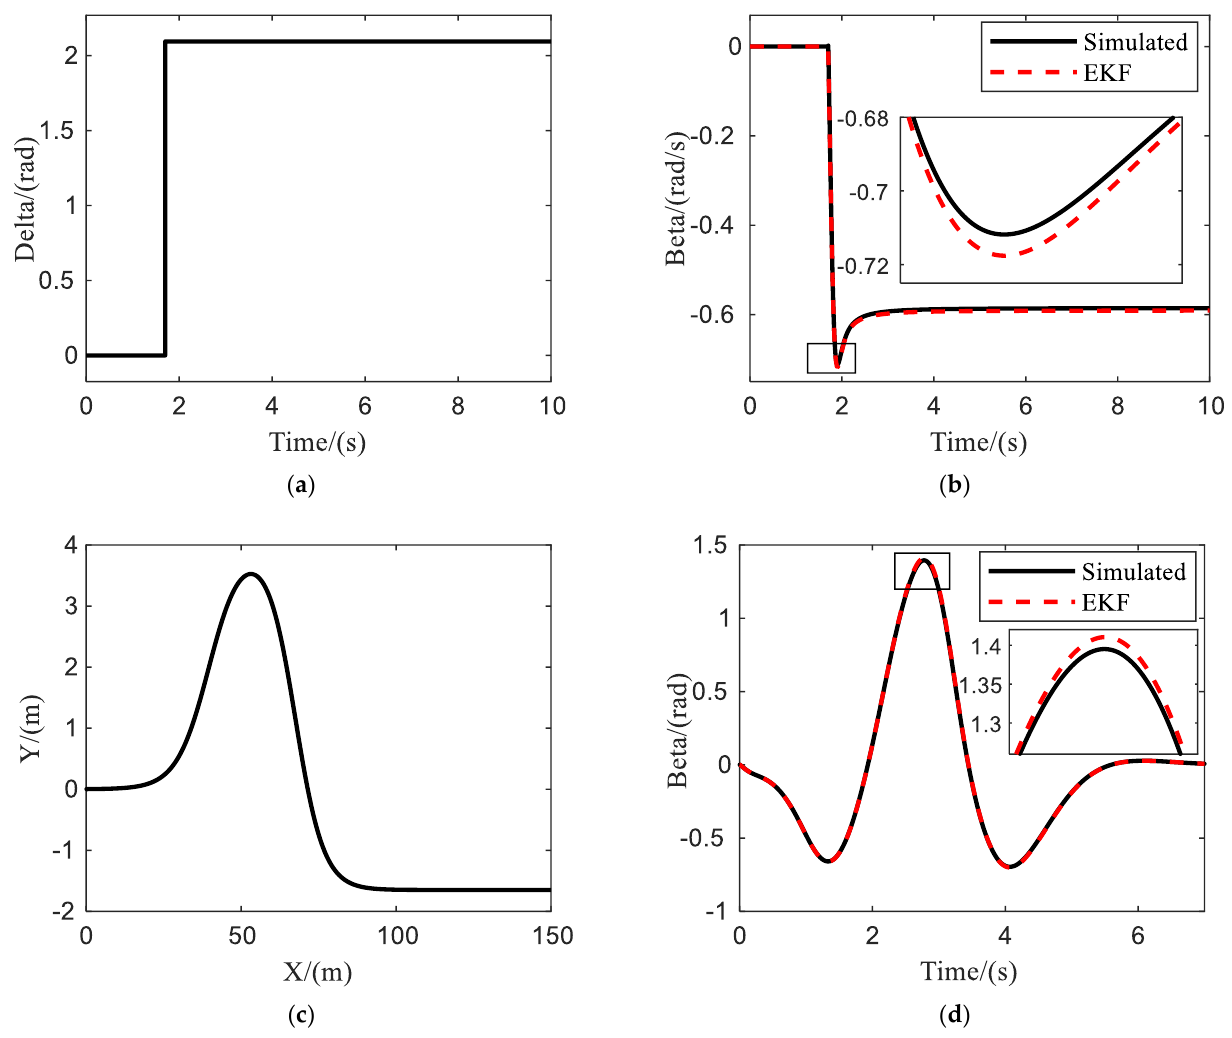
Figure 5. Parameters estimated by EKF and simulated by CarSim: ( a ) designed steering wheel angle; ( b ) yaw rate1; ( c ) designed path; ( d ) yaw rate2.